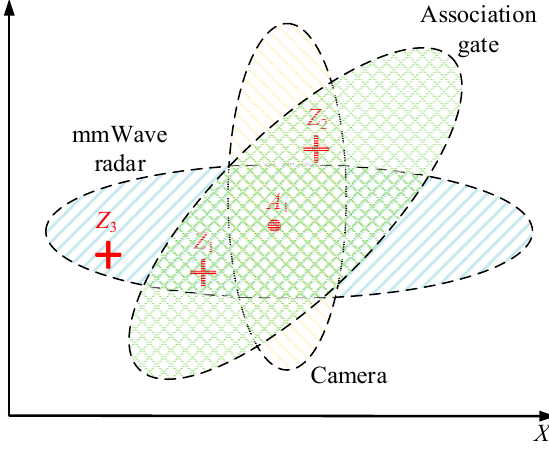
Figure 8. Setting up an association gate.